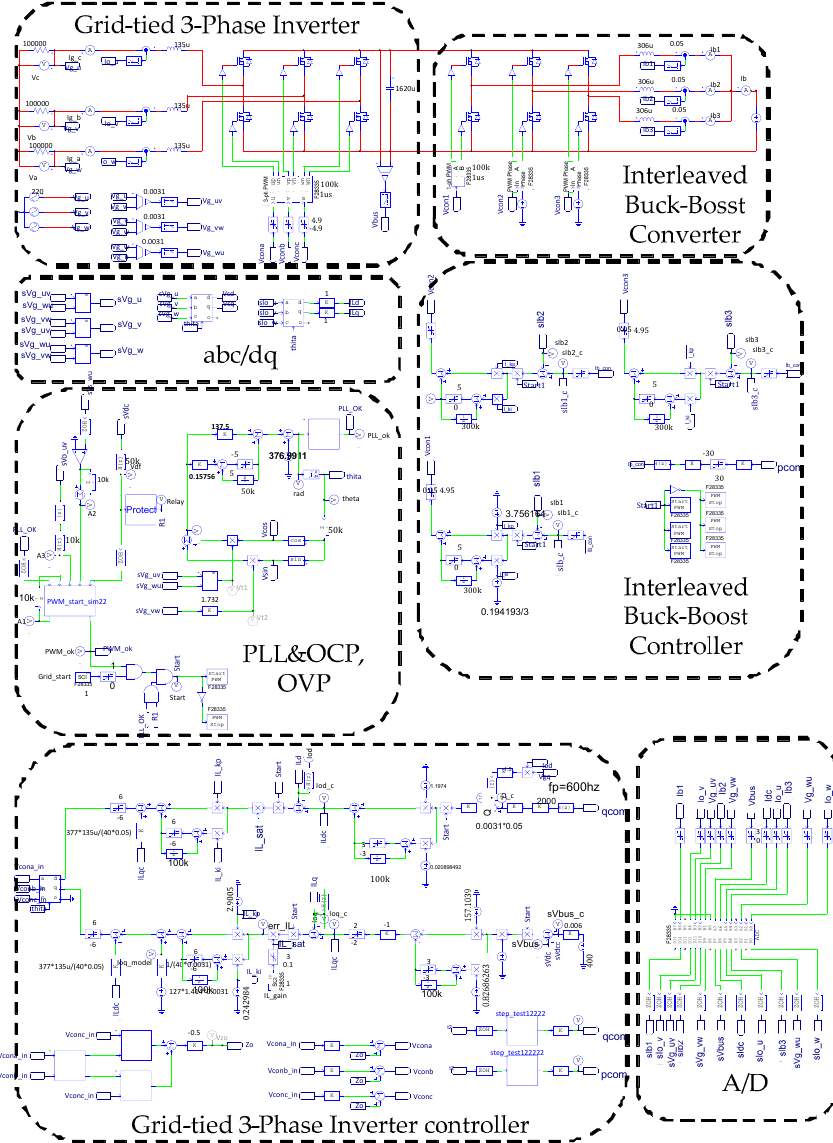
Figure 15. The power simulation software model of the proposed VRFB PCS.